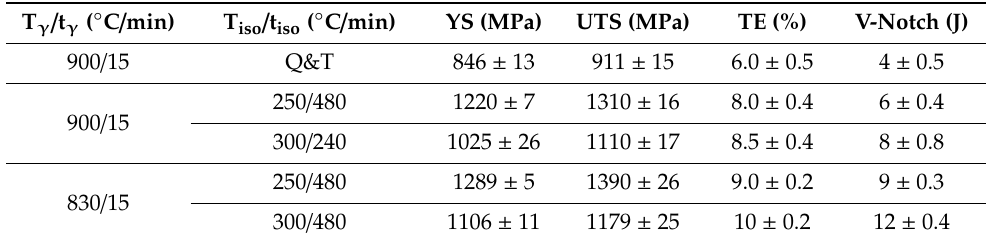
Table 6. Mechanical properties in carburized steel under di ff erent processes. Q&T: quenching and tempering; YS: yield strength; UTS: ultimate tensile strength; TE: total elongation; V-notch: impact